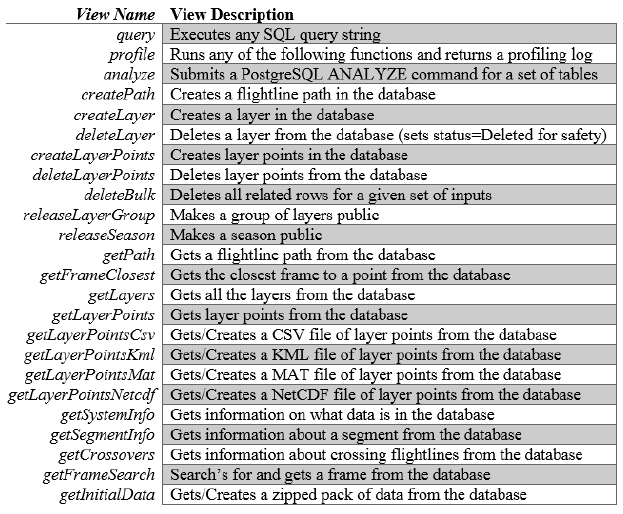
Figure 7. A complete list of the OPS Django views and a brief description of each.